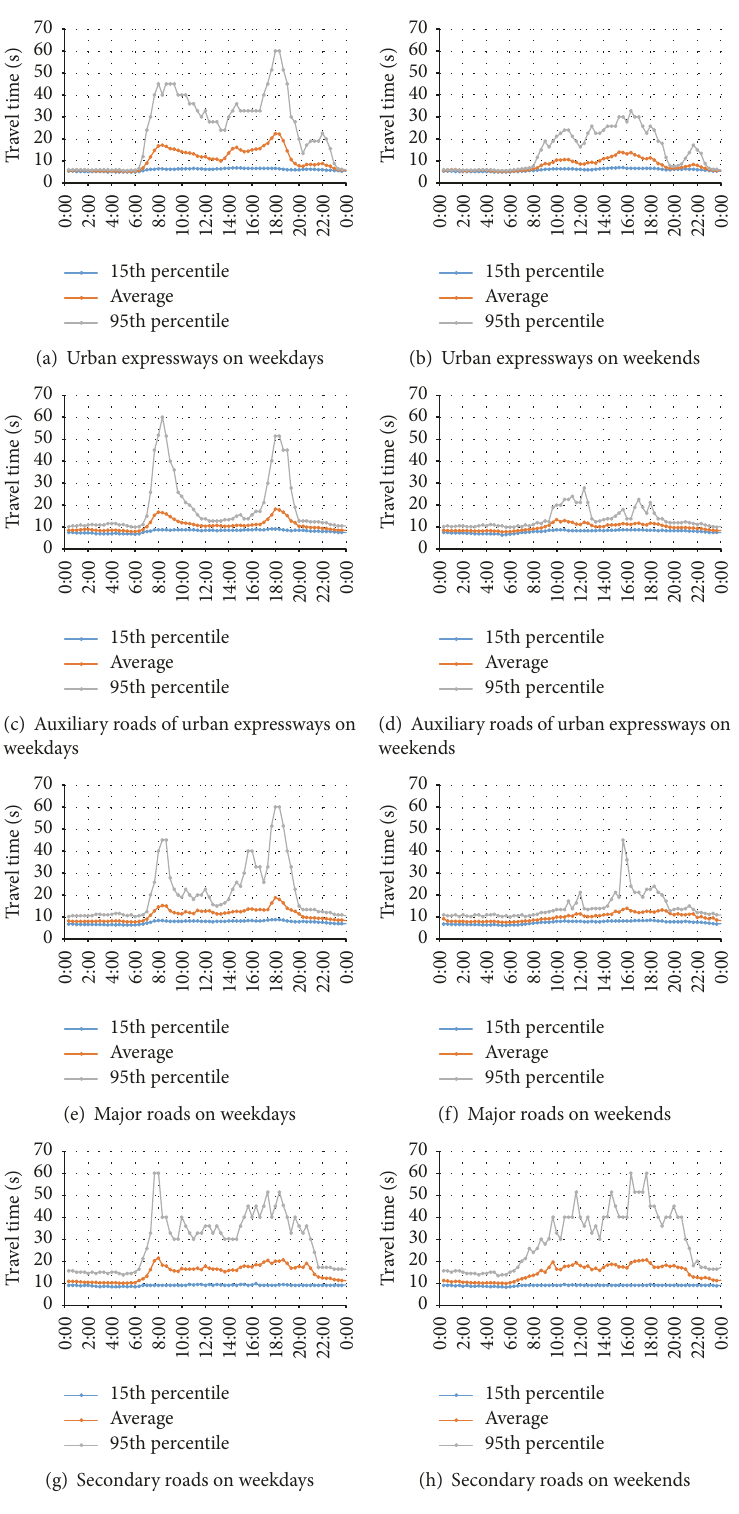
Figure 2: Unit distance travel time for different types of road through the